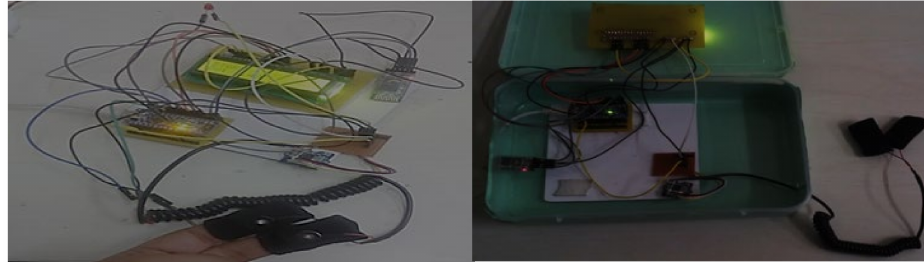
Figure 3. Stress detector system used in our study.